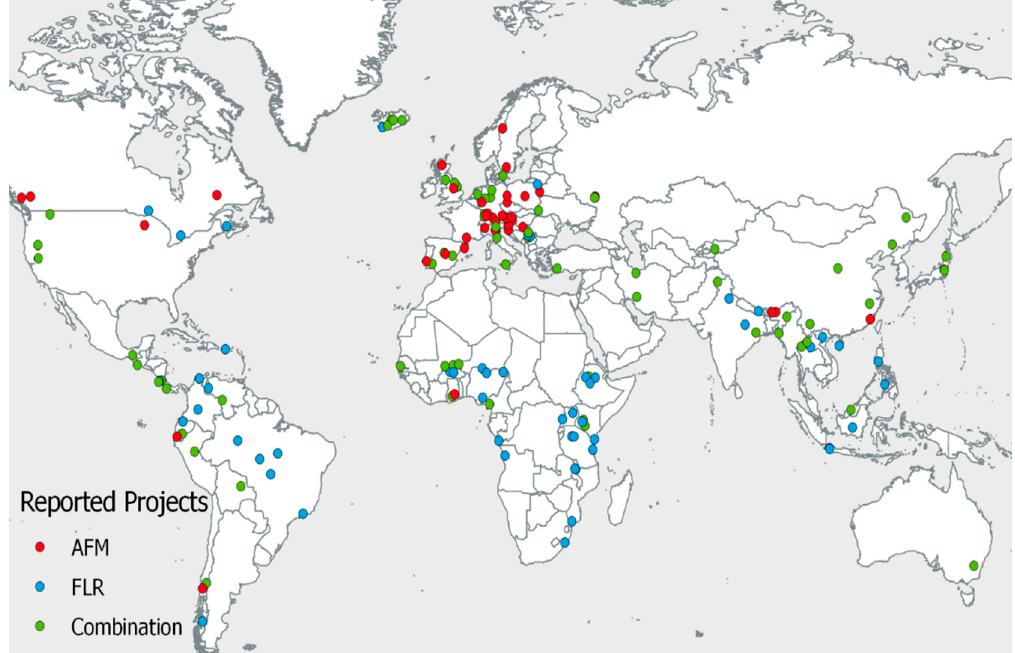
Figure 2. Distribution of projects reported in the survey by type of project. AFM: adaptive forest management and FLR: Forest and Landscape Restoration. Table 2. Topics addressed were concerning project success and failure and encountered problems and solutions, with corresponding categories assigned to responses and their number of occurrences in the survey data, as indicated in square brackets. The associated sections of this publication are indicated in parentheses behind the respective topics. AFM: adaptive forest management and FLR: Forest and Landscape